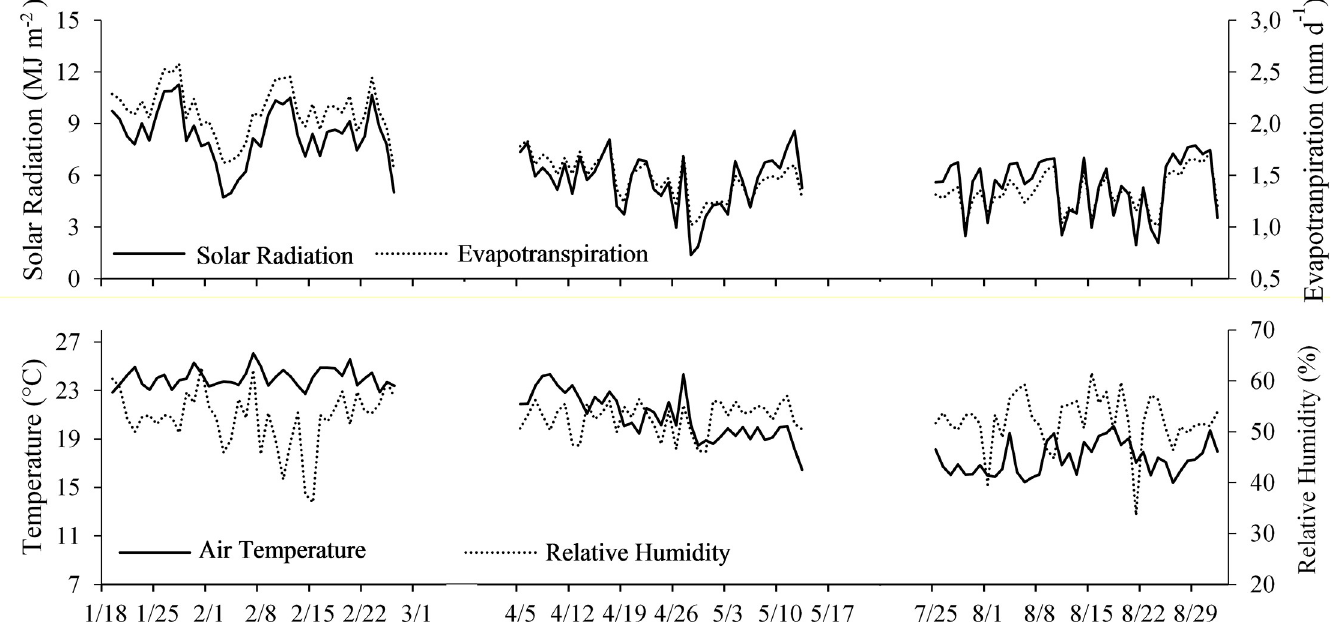
Fig 2. Daily variation of solar radiation, reference evapotranspiration, temperature and relative humidity for the three cycles of lettuce cultivation in Vic¸osa-MG in 2017.